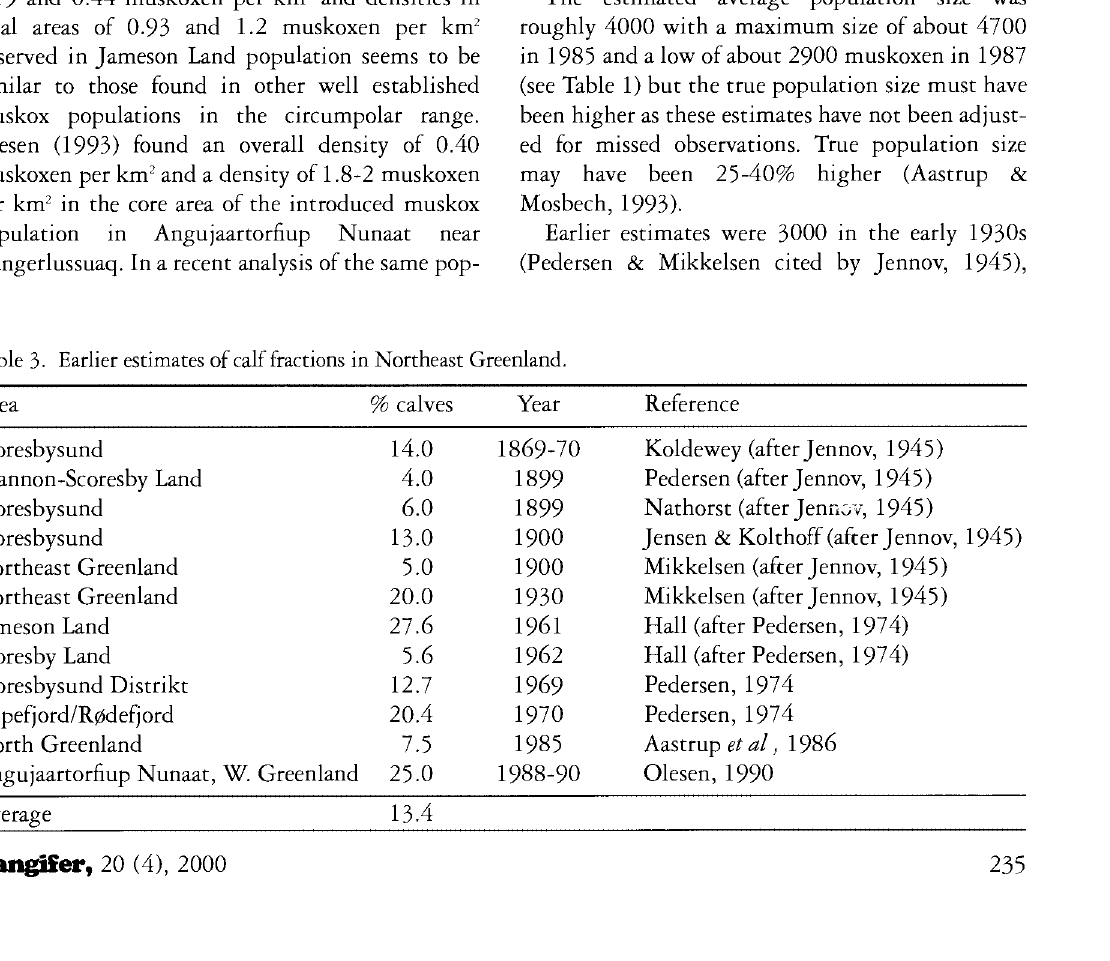
Table 3. Earlier estimates of calf fractions in Northeast Greenland.